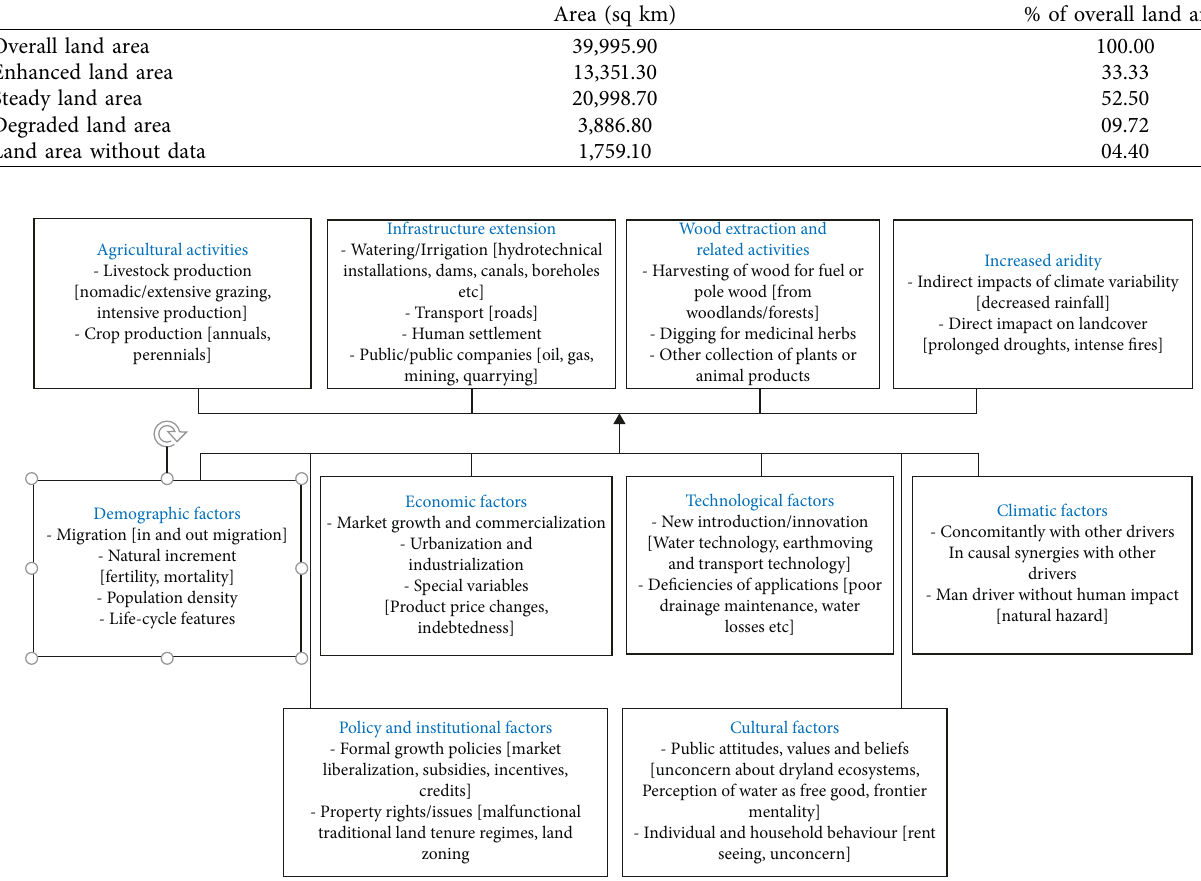
Figure 3: The main drivers and gravities of land degradation.